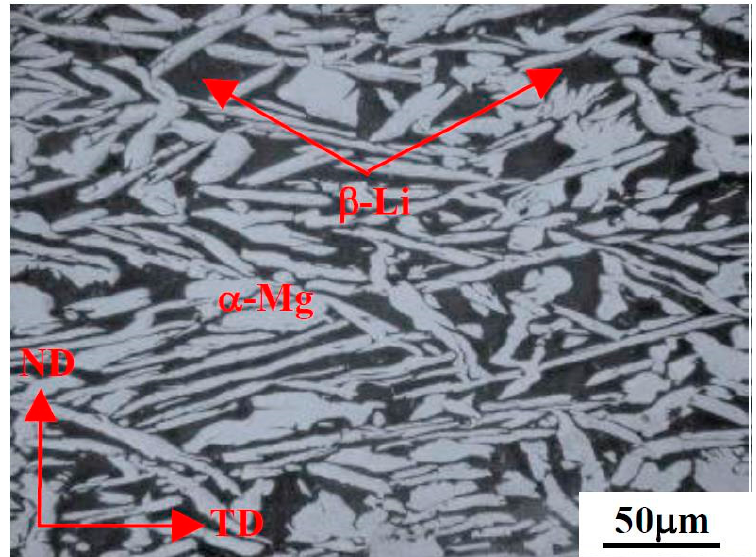
Figure 2. Optical microstructure of the as-rolled Mg-8%Li alloy.